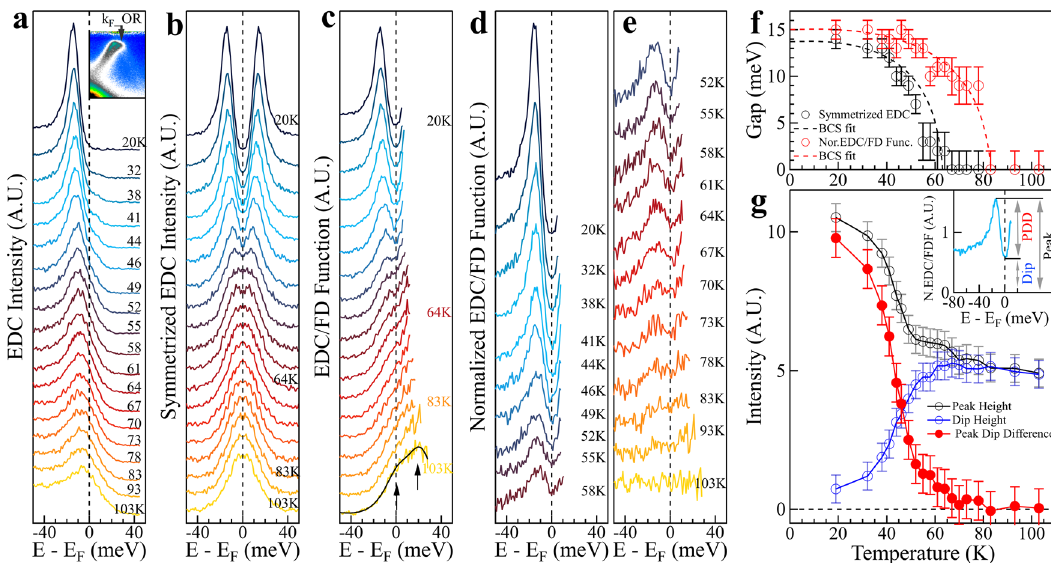
Fig. 2 Temperature dependence of the energy gap and the associated spectral weight along a Fermi surface. a Photoemission spectra (EDCs) measured at different temperatures at the Fermi momentum on the right side of the outer Fermi surface (k F _OR) along the momentum Cut 1. The location of the momentum Cut 1 is illustrated in Fig. 1a and the location of the Fermi momentum k F _OR is shown in the upper-right inset. b The corresponding symmetrized EDCs at different temperatures obtained from ( a ). c EDCs at different temperatures obtained from dividing the original EDCs in ( a ) by their corresponding Fermi distribution functions (FD Function). The solid black line at the bottom represents the fi tted curve of the 103 K data by two Lorentzians which correspond to two bands, the outer-right band is at the Fermi level while the other inner-right one lies ~20 meV above the Fermi level as indicated by two arrows. d , e EDCs at different temperatures obtained from dividing the EDCs in ( c ) by the fi tted curve at 103 K. For clarity, the obtained normalized EDCs are displayed in ( d , e ). f Temperature dependence of the energy gap. The black circles show the energy gap obtained by picking the peak position of the symmetrized EDCs in ( b ). The red circles show the gap obtained by picking the peak position of the normalized EDCs in ( d , e ). The dashed lines show the fi tted curve of the energy gap by the BCS formula. g Temperature dependence of the spectral weight obtained from the normalized EDCs in ( d , e ). As shown in the upper-right inset, here we take three spectral intensities: the height of the peak below the Fermi level, the height of the dip at the Fermi level and the difference between the peak height and the dip height (PDD). The corresponding three spectral intensities as a function of temperature are shown by the empty black circles, empty blue circles and the red solid circles, respectively. Error bars re fl ect the uncertainty in determining the EDC peak position and spectral the gap size ( Δ ) from the peak position as plotted in Fig. 2f (black circles). From the symmetrized EDC (Fig. 2b), the dip structure at the Fermi level represents a gap opening; it disappears around 64 K for the Fermi momentum of the outer Fermi surface, k F _OR, that appears to be consistent with the previous results 23 – 25 .